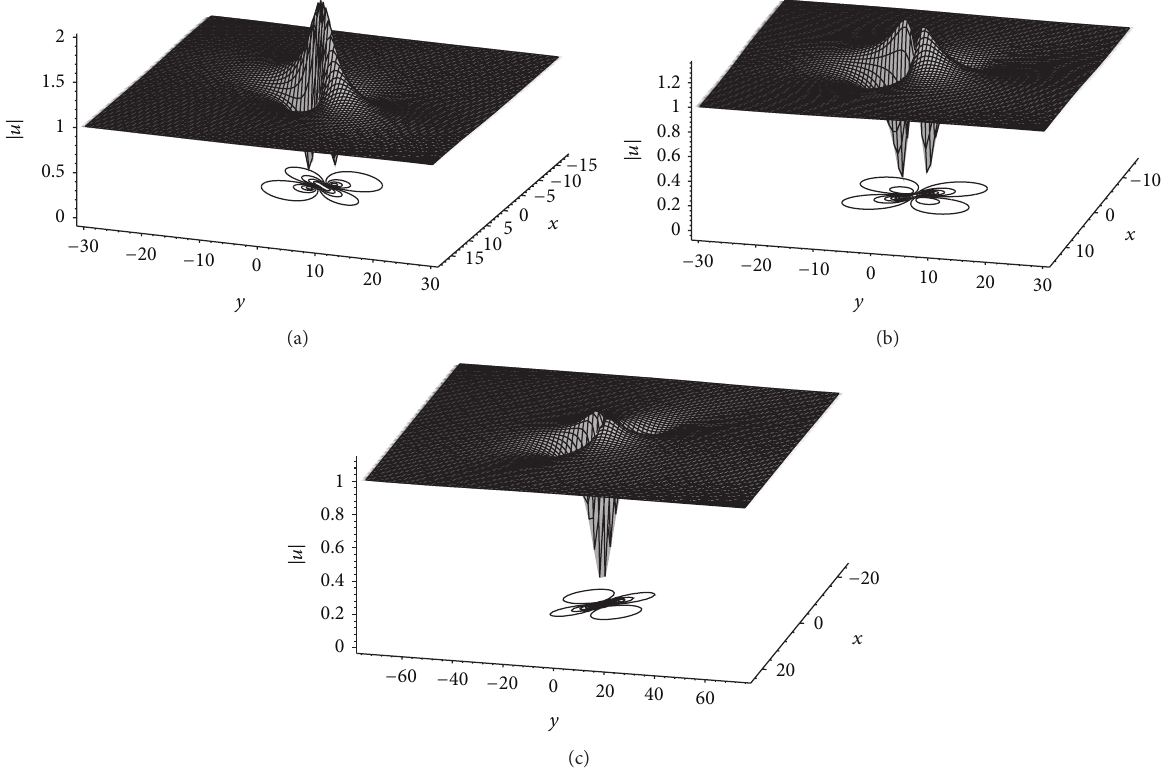
Figure 1: Spatial structures of the rational solution (11): (a) 𝑘 = 0, (b) 𝑘 = 0 . 5, (c) 𝑘 = 0 . 8 and 𝑢 0 = 𝑙 = 1, and 𝑞 = 1 / 2. Curved lines drawn at the bottom of this figure are contour